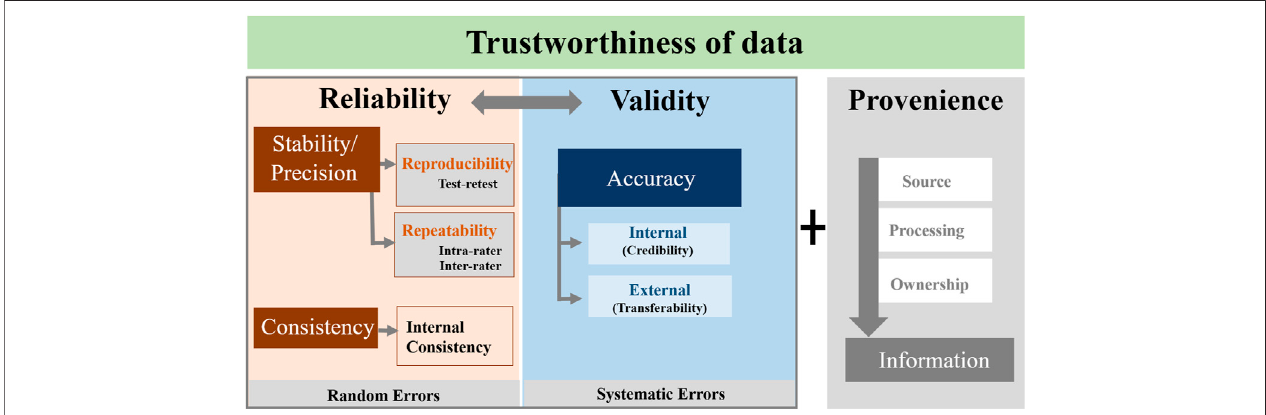
FIGURE 1 | Indicators of data trustworthiness, data reliability, data validity and data provenience. (1) Stability/Precision and consistency in data play a major role in reliability assessment. (2) Validity assesses the trueness and accuracy of measured data while considering consistency closeness. (3) Data Provenience supports the con fi dence or validity of data by providing detailed information (metadata) on data origin and its processing steps in a consistent manner.